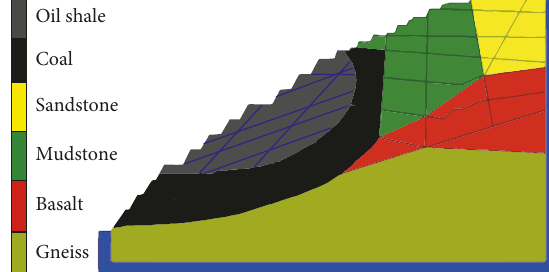
Figure 7: DDA model of the slope in the Fushun West Open-Pit Mine for numerical calculation and analysis.